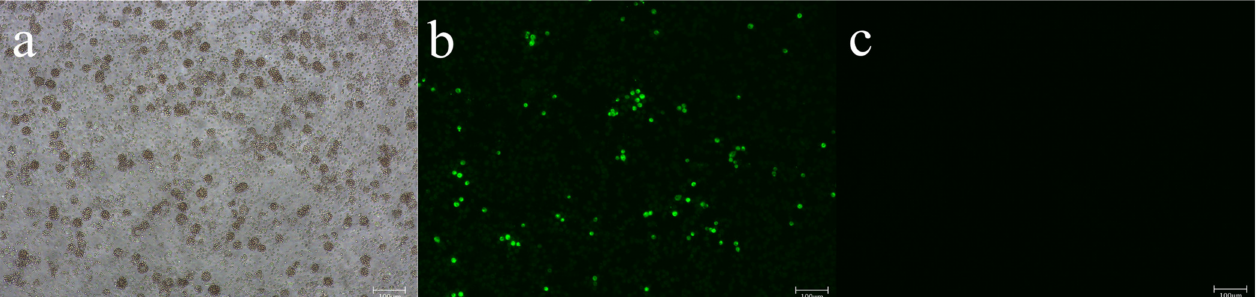
Figure 2. Confirmation of ASFV isolation (Korea/Pig/Yeongwol/2021) from spleens originating from the 17th infected farm. ( a ) HAD 6 days post inoculation of the first passage ( × 100) and ( b ) FAT 4 days post inoculation of the first passage ( × 100) compared with PAM cells infected with mock ( c ).